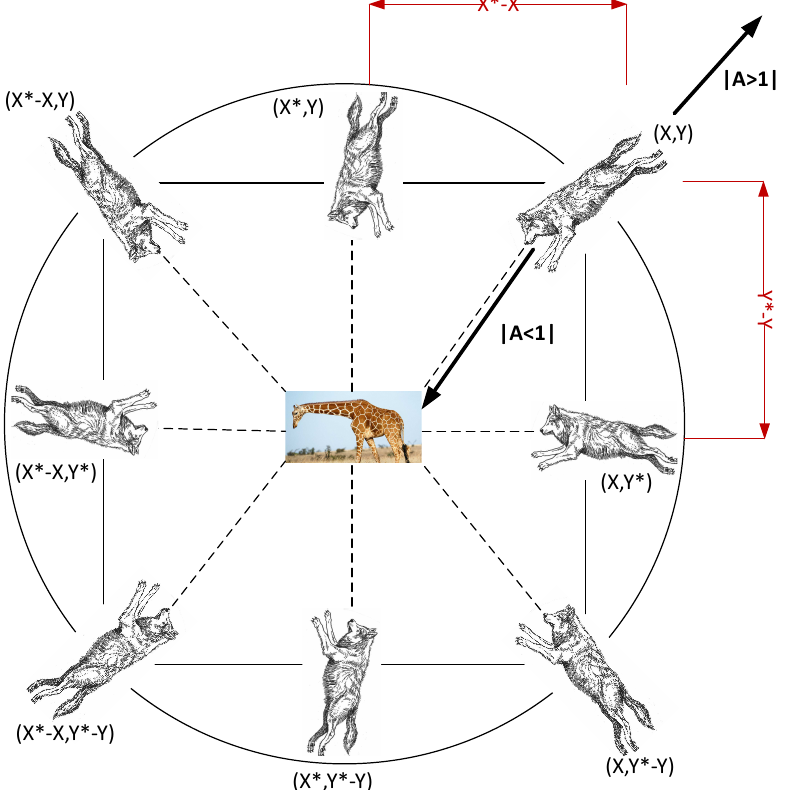
Figure 4. Position Updating Mechanism of Wolves and Effect of